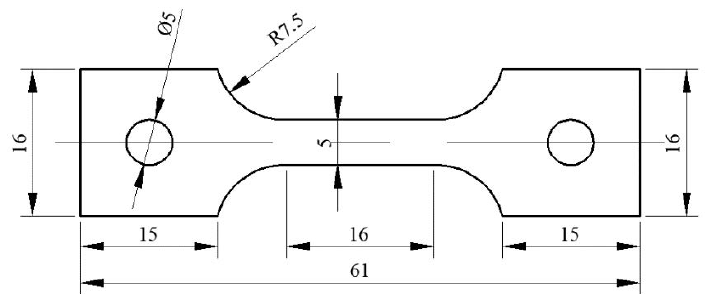
Figure 2. Dimensional drawing of tensile specimen (units: mm).